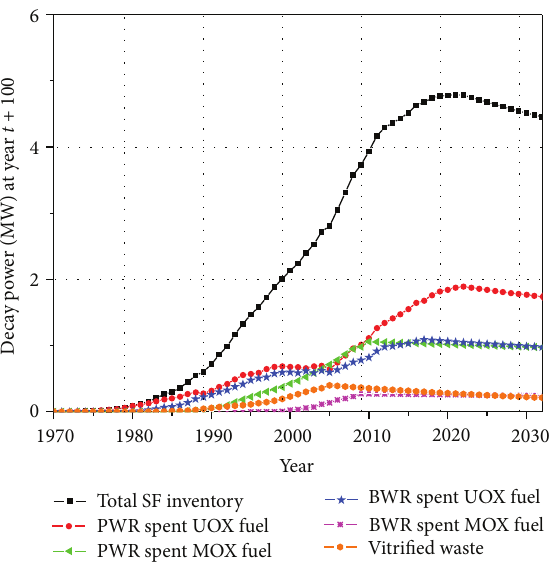
F 7: Decay power of stored nuclear material (SNF and vitri�ed HLW) hundred years aer date is shown.